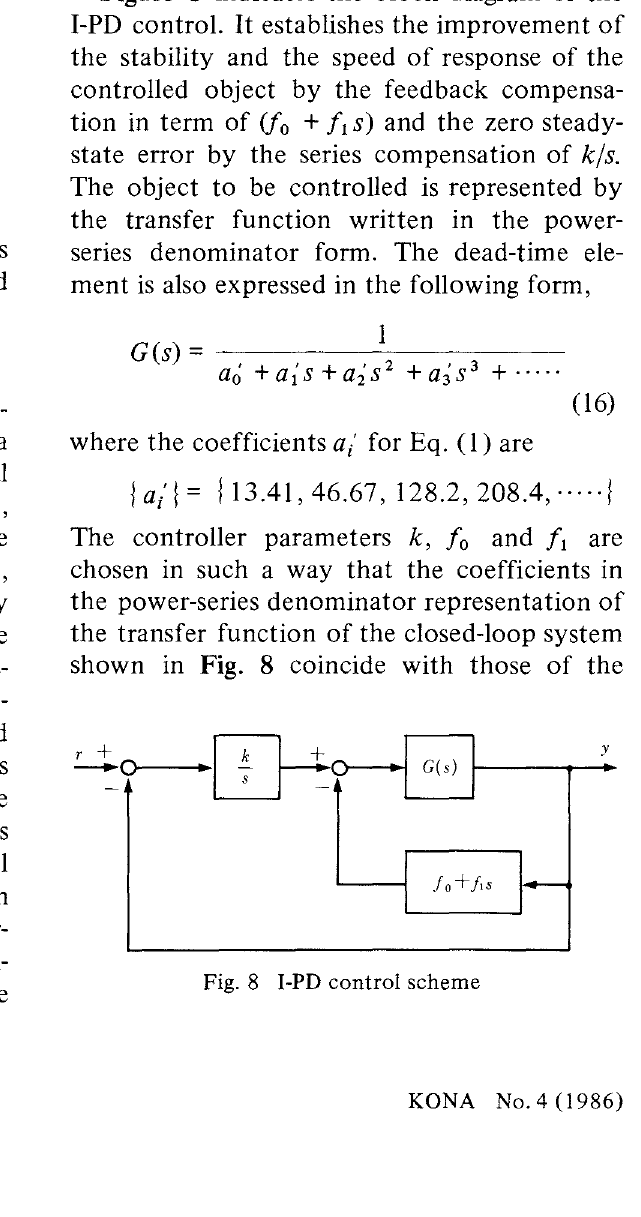
Fig, 7 Effect of parameter Q in Kalman filter_